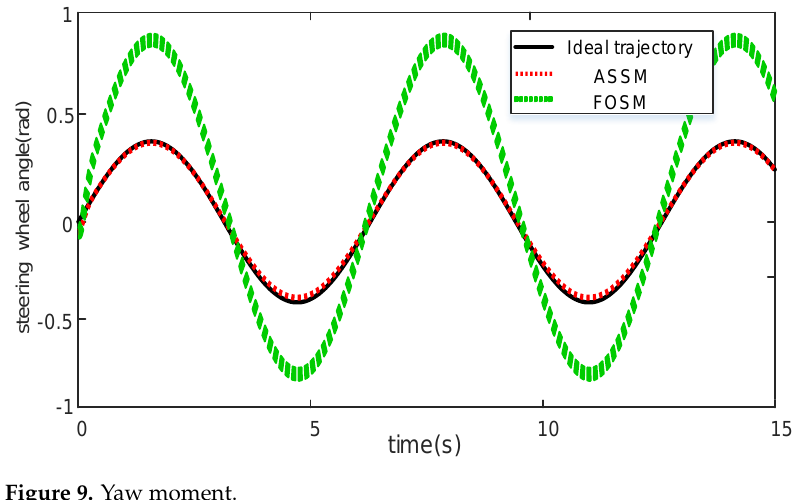
Figure 9. Yaw moment.